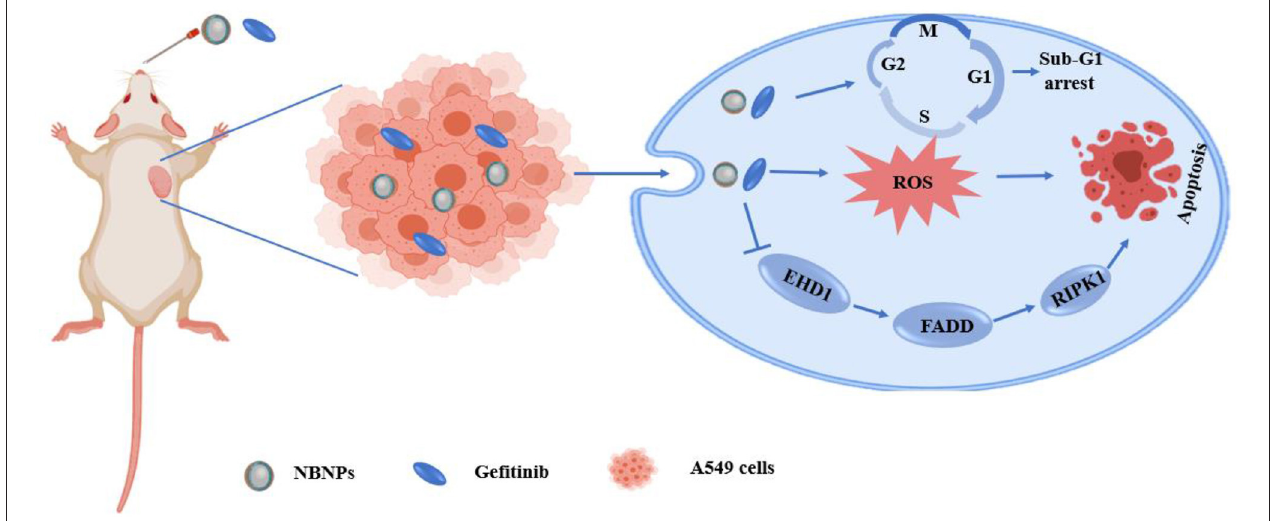
FIGURE 3 | Schematic illustration of the mechanism of the natural borneol nanoparticles (NBNPs) enhanced gefitinib sensitivity in A549 cells when loaded with natural